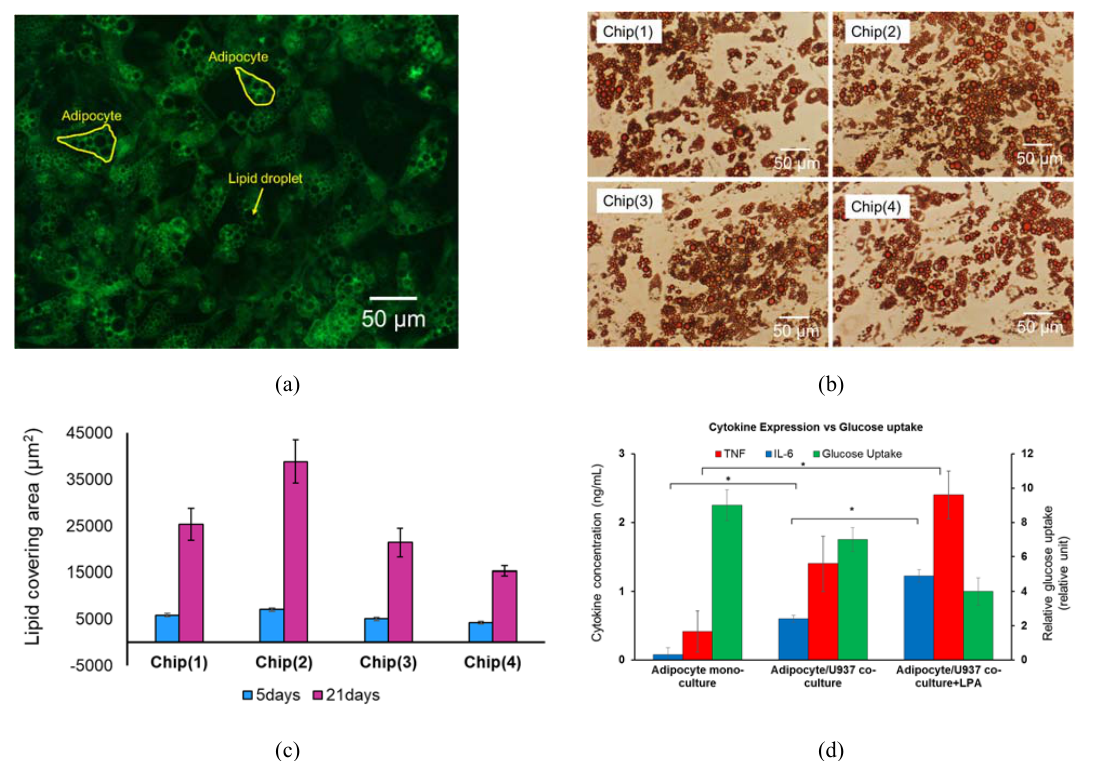
Figure 7. Adipocytes monocultured on ‐ chip. ( a ) Fluorescence images of differentiated adipocytes after 14 days of differentiation medium treatment. ( b ) Lipid droplets within the adipoctes highlighted with Oil Red O staining. ( c ) Total lipid droplet coverage area in adipocyte culture compartments at 5 and 24 days after diffrentation medium treatment. ( d ) Glucose uptake vs. Il ‐ 6 and TNF ‐α expression at 24 h. Data were represented as mean ± SEM. * indicate statistical significance at p < 0.01.